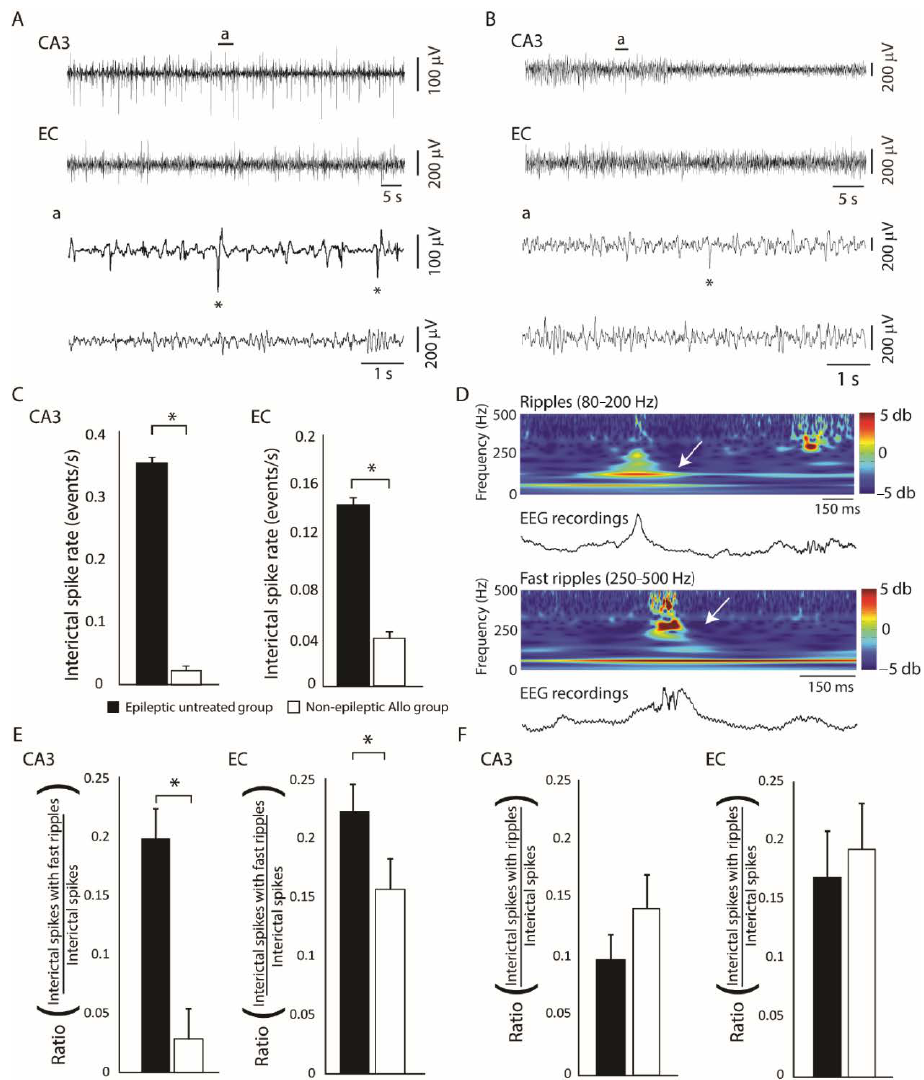
Figure 4. ( A ): Representative EEG recordings from the CA3 region of the hippocampus and the entorhinal cortex ( EC ) of an epileptic untreated animal. ( B ): Representative recordings in an epileptic animal that was treated with allopregnanolone. Insets ( a ) show interictal spikes (asterisks) on a lower timescale. ( C ): Bar graphs showing rates of interictal spikes in the epileptic untreated and non-epileptic allopregnanolone-treated group. Rates of interictal spikes in CA3 and EC were significantly lower in the non-epileptic allopregnanolone-treated group compared to the epileptic untreated group (* p < 0.05). ( D ): Example of a ripple (80–200 Hz) and a fast ripple (250–500 Hz) that occurred in association with an interictal spike, in an epileptic untreated animal. The wavelet analysis is shown to illustrate ripples and fast ripples (white arrows). ( E ): Bar graph showing ratios of interictal spikes with fast ripples on the total number of interictal spikes. In both CA3 and EC, rates of interictal spikes with fast ripples occurred at significantly lower rates in the non-epileptic allopregnanolone-treated group compared to the epileptic untreated group (* p < 0.05). ( F ) : Bar graph showing ratios of interictal spikes with ripples on the total number of interictal spikes. No significant differences were observed between groups. Panels were modified from the study of Lévesque et al. [14].